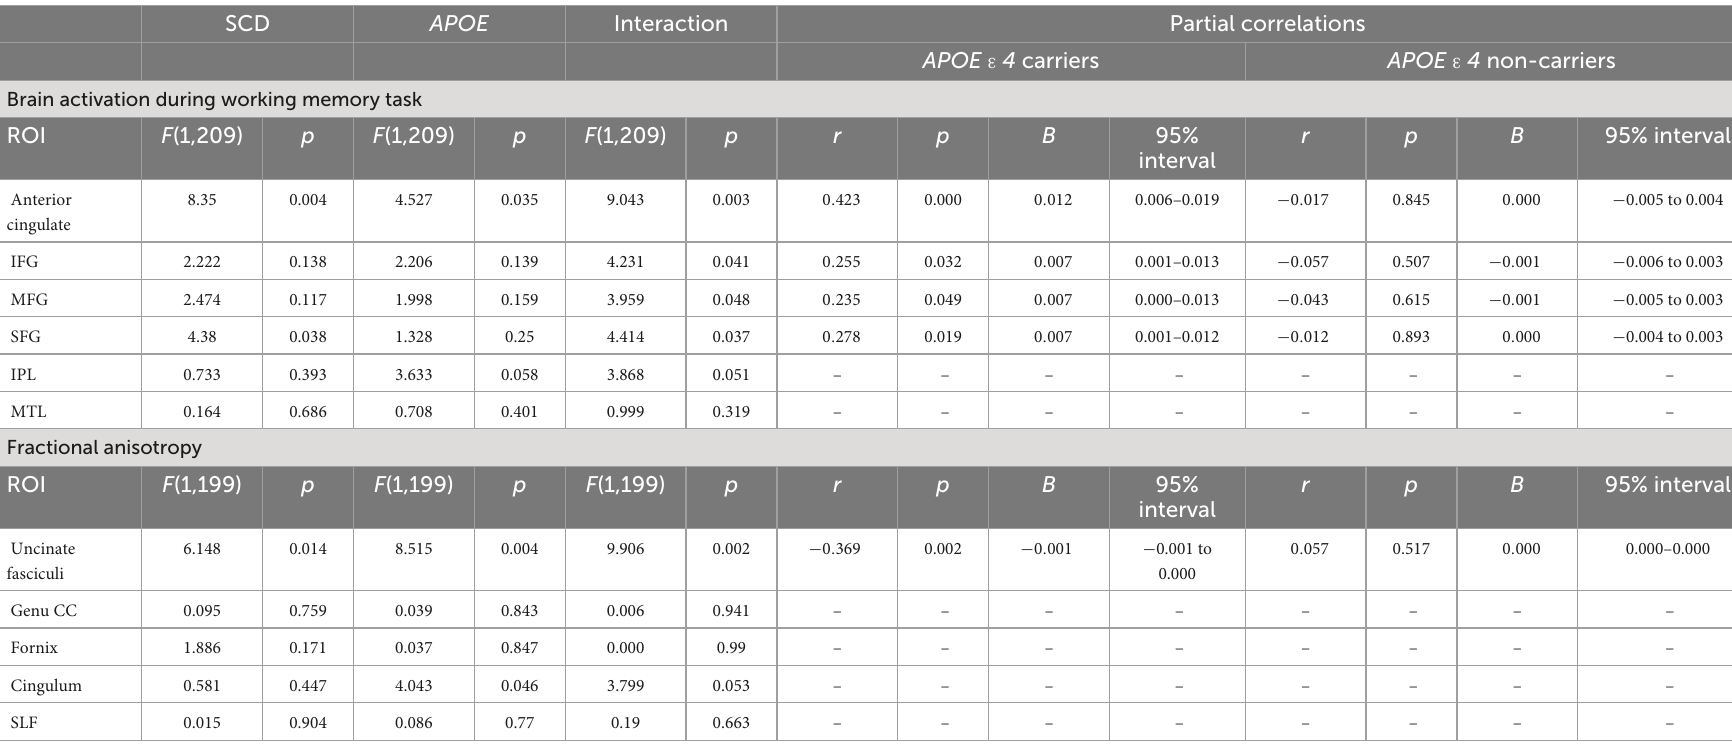
TABLE 3 Linear regression of APOE ε 4 genotype with SCD (MFQ_FF) on brain activation during a working memory task and on fractional anisotropy in the different brain regions adjusting for age, sex, and years of education. SCD APOE Interaction Partial correlations